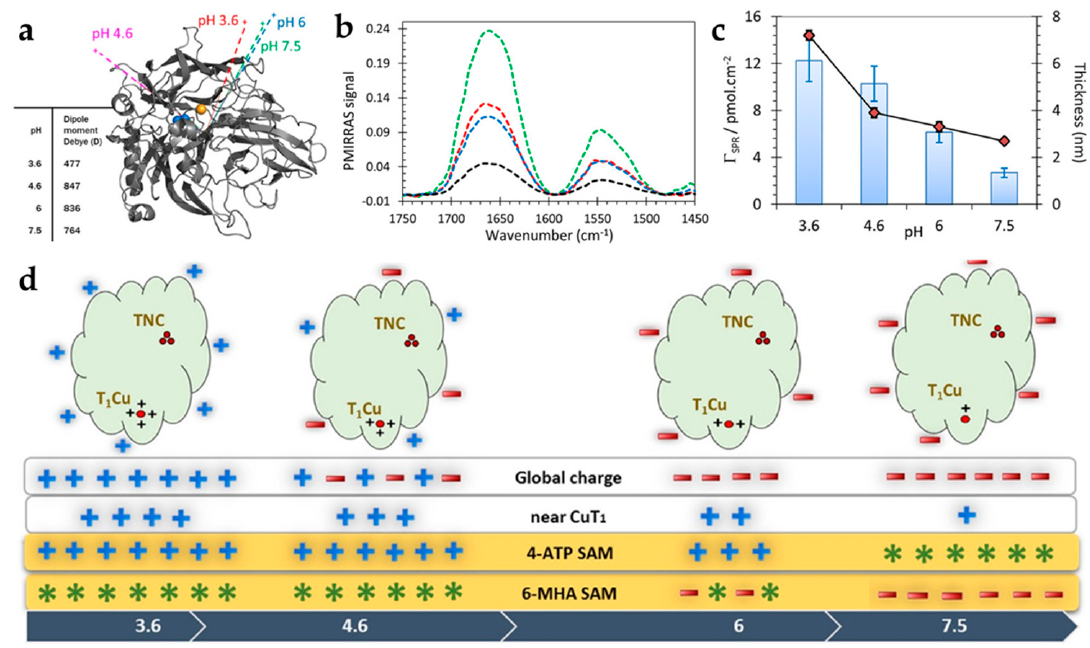
Figure 6. ( a ) Mv BOD structure and dipole moments in the pH range 3.6 to 7.5. CuT 2 /T 3 contains three copper atoms marked in blue and CuT 1 with a single copper atom marked in gold; ( b ) PMIRRAS signals of Mv BOD-modified bioelectrodes with 6-MHA SAM; ( c ) Enzyme coverage ( Γ ) and enzyme layer thickness at different pH recorded by SPR ellipsometry; ( d ) Cartoon illustration of the charge distributions of Mv BOD at different pH levels, with the CuT 1 center, as well the 6-MHA and 4-ATP SAM-modified electrode surfaces. The neutral electrode surface is indicated with green stars. Reproduced with permission from [75]. Copyright 2018, American Chemical